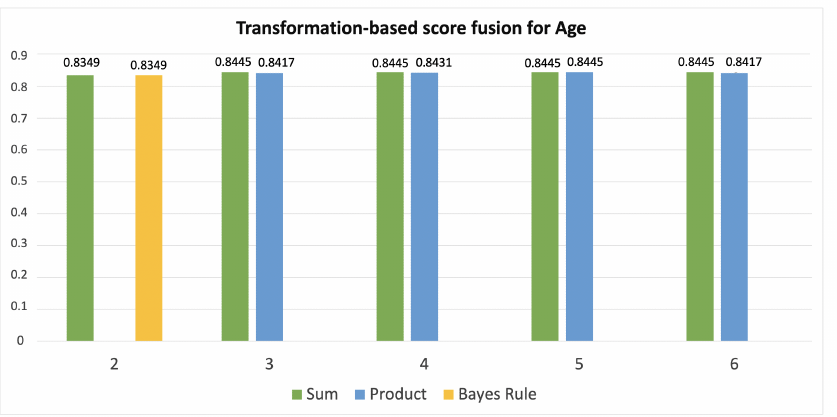
Figure 5. The results of combining 2, 3, 4, 5, and 6 classifiers in age recognition using sum, product and Bayes rule as fusion strategies.